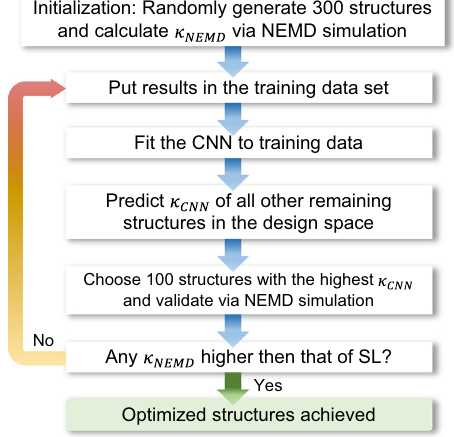
Schematic of the iterative search algorithm used to discover unexpected thermal conductivity ( κ l ) enhancement in aperiodic superlattice systems.